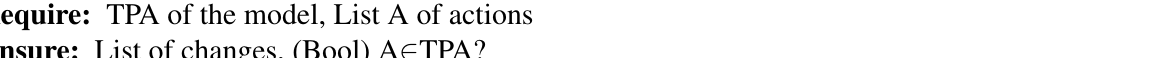
Algorithm 2 WIAA